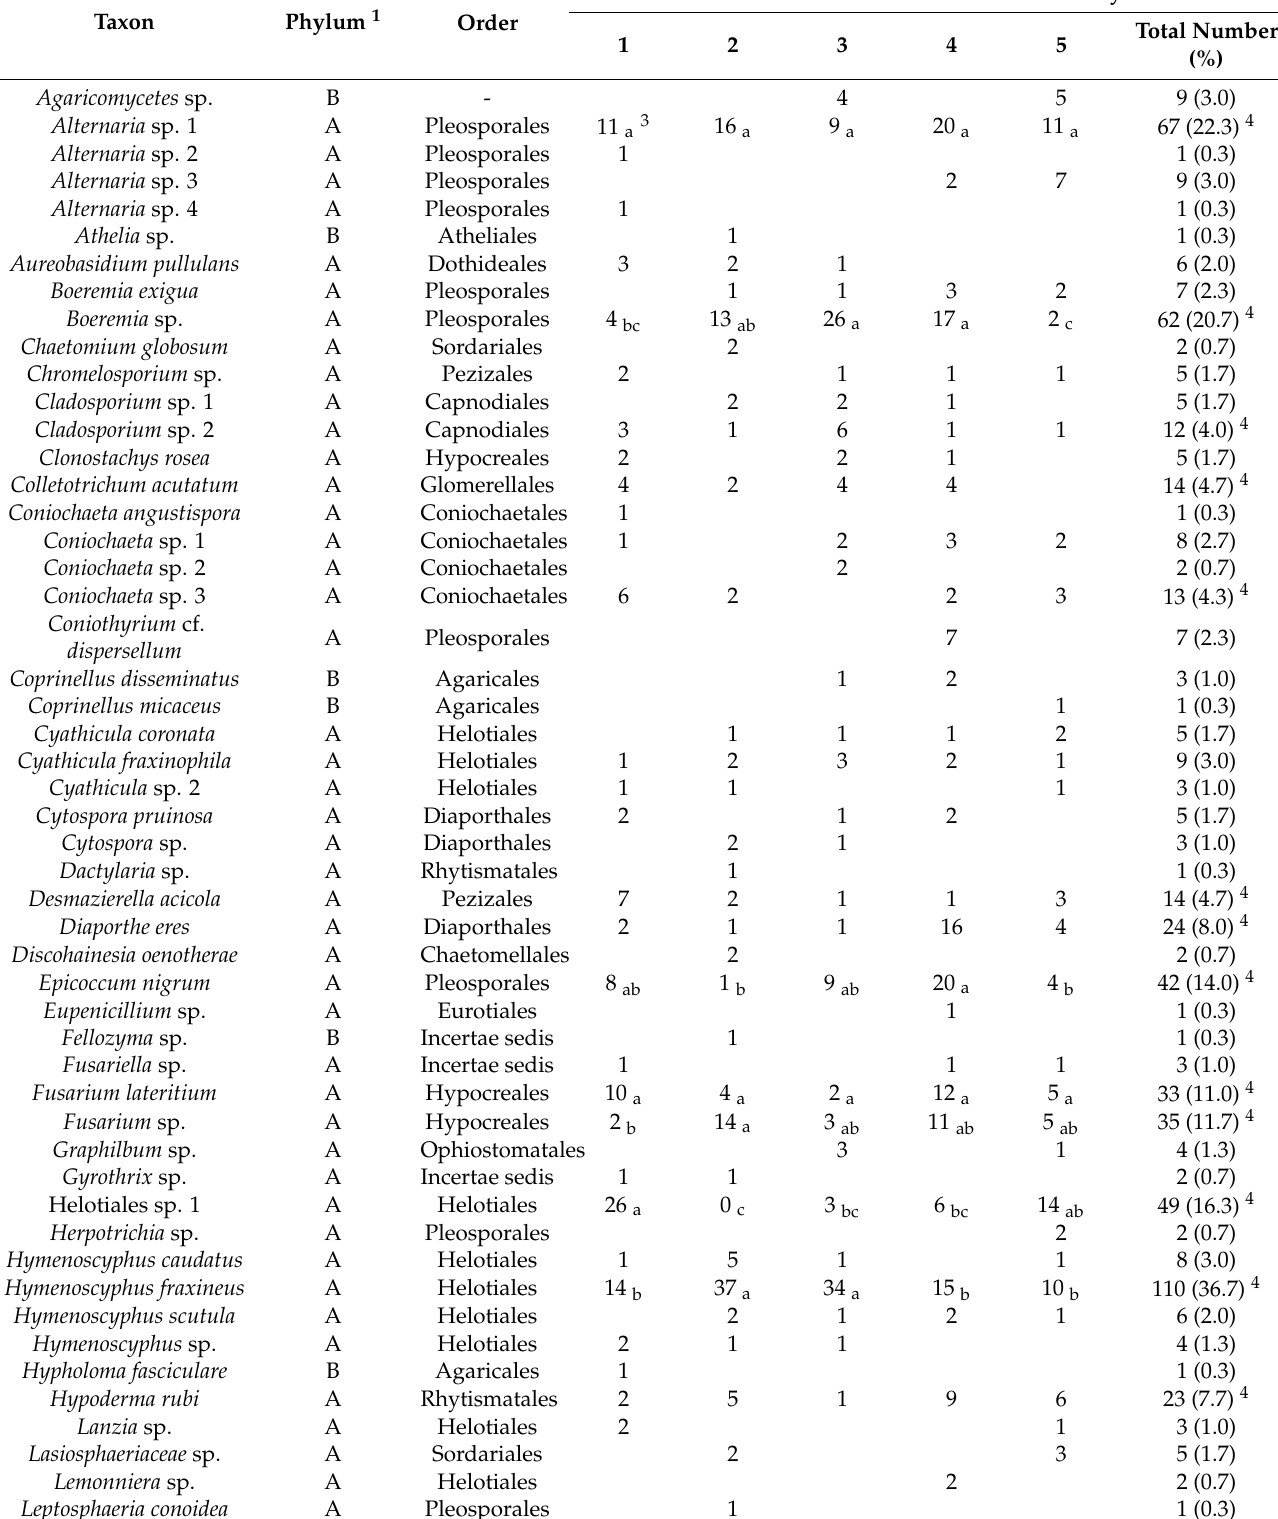
Table 2. Fungi isolated from the previous year’s leaf petioles of F. excelsior in the litter in five forest stands in southern Poland in spring